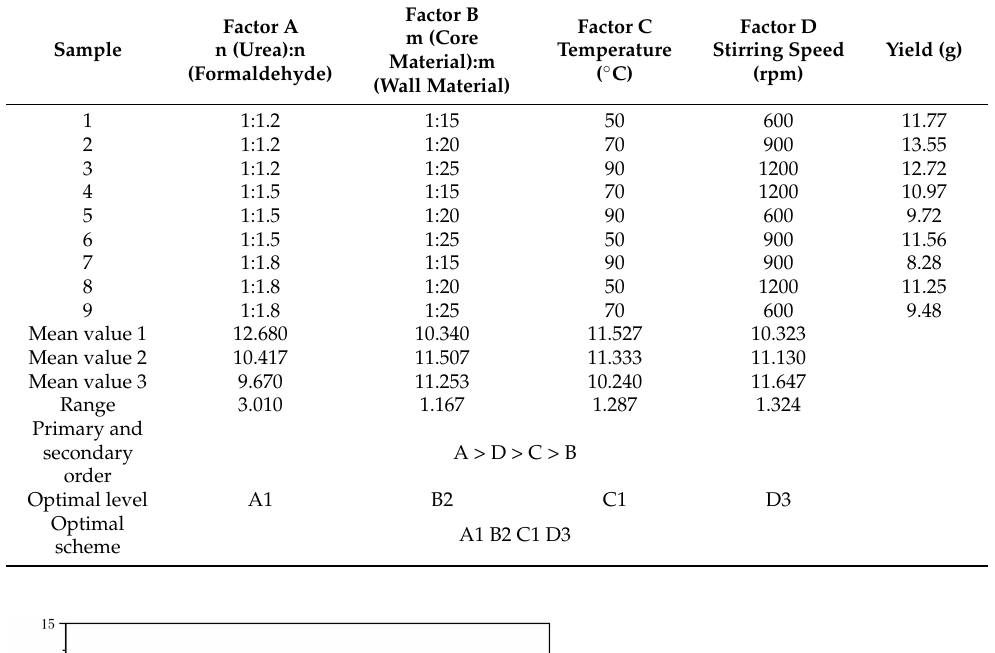
Table 7. Analysis of microcapsule yield results.